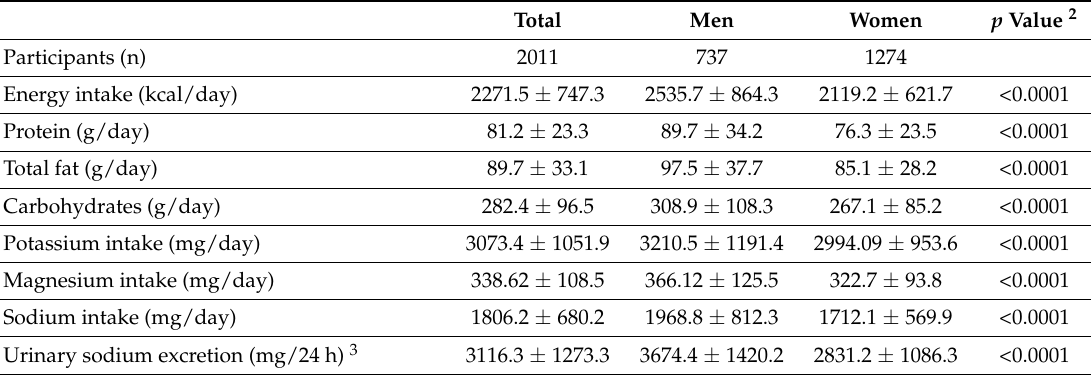
Table 2. Dietary characteristics of the study sample by sex 1